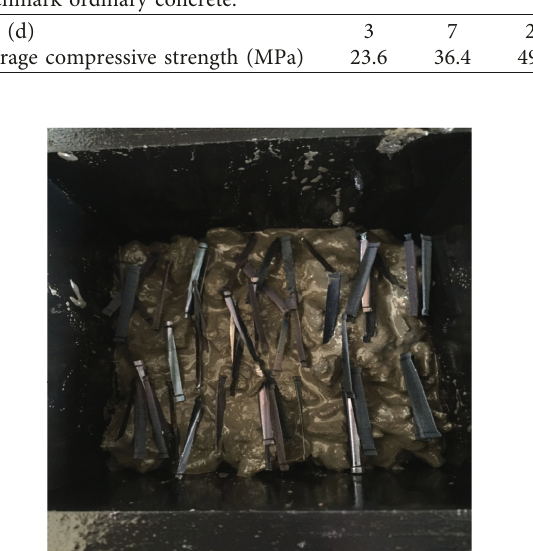
Figure 1: Directionally distributed steel fibres in a concrete